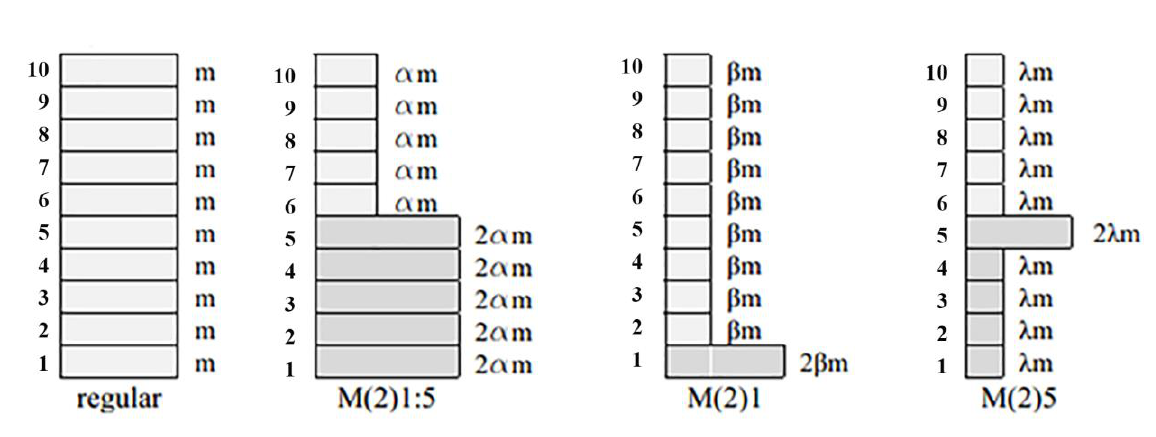
Fig. 2. Assumed Coefficients and